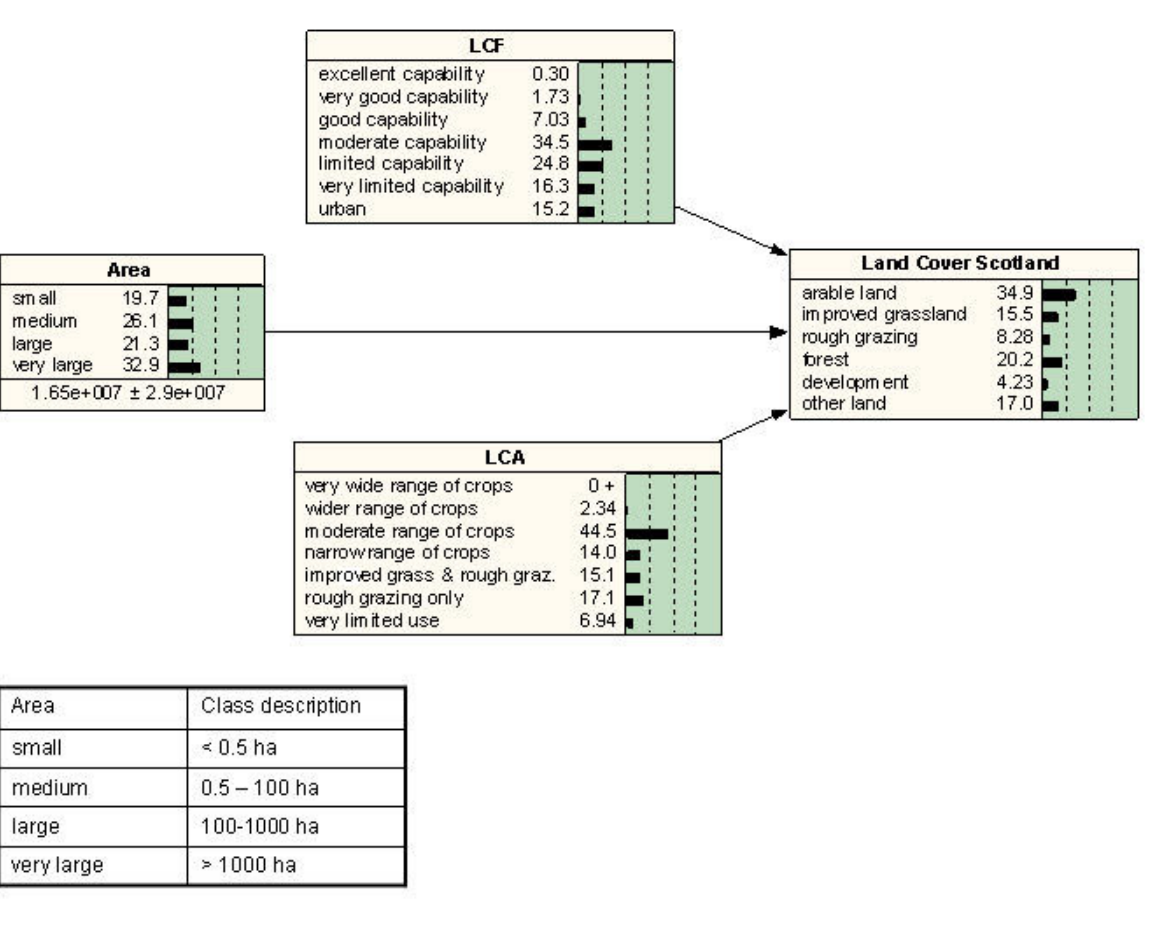
Fig. 2. Model 1 (for the continuous variables, the average and the standard deviation are given below the probability